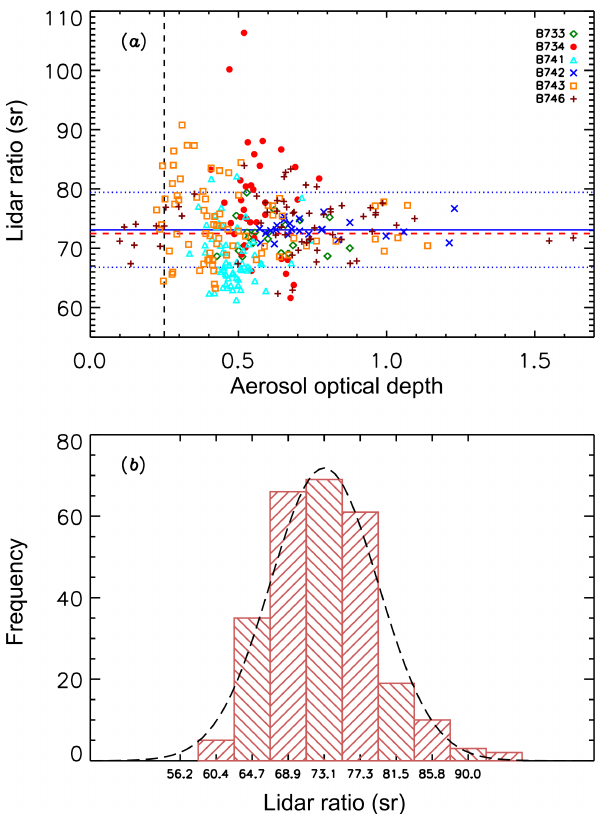
Figure 2. (a) Lidar ratio and AOD, determined for each lidar pro- file (see text). The data points are colour-coded with the flight num- ber. The horizontal blue solid line indicates the mean, the blue dot- ted lines indicate one standard deviation from the mean, and the dashed red line indicates the median. The vertical dashed line in- dicates the threshold (AOD > 0 . 25) that has been applied to the data set. (b) Histogram of lidar ratio determinations, for 270 profiles with AOD > 0 . 25. Mean: 73.1sr, standard deviation: 6.3sr, median: 72.5sr. A gaussian curve with the same mean and standard devia- tion is overplotted (dashed